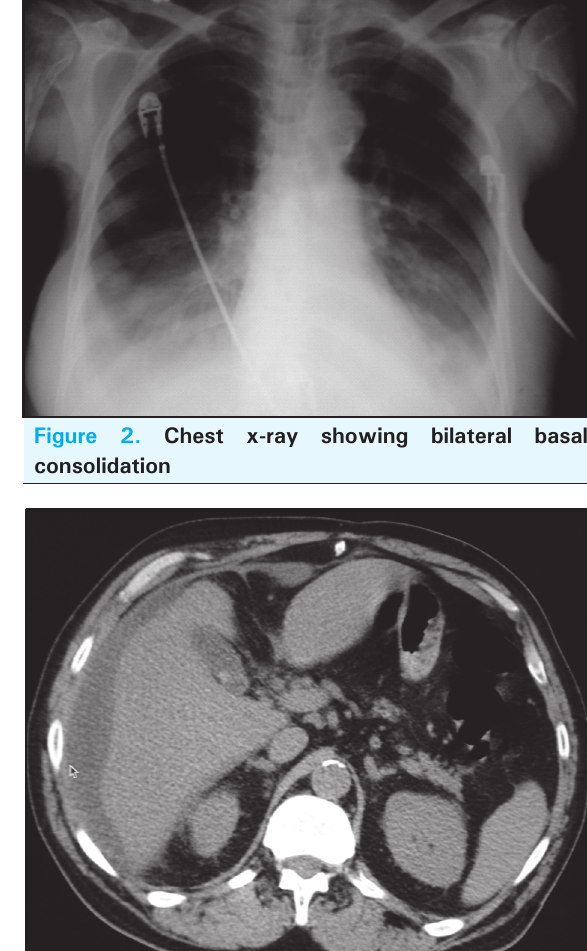
Figure 3. computerised tomographic scan showing free intraperitoneal